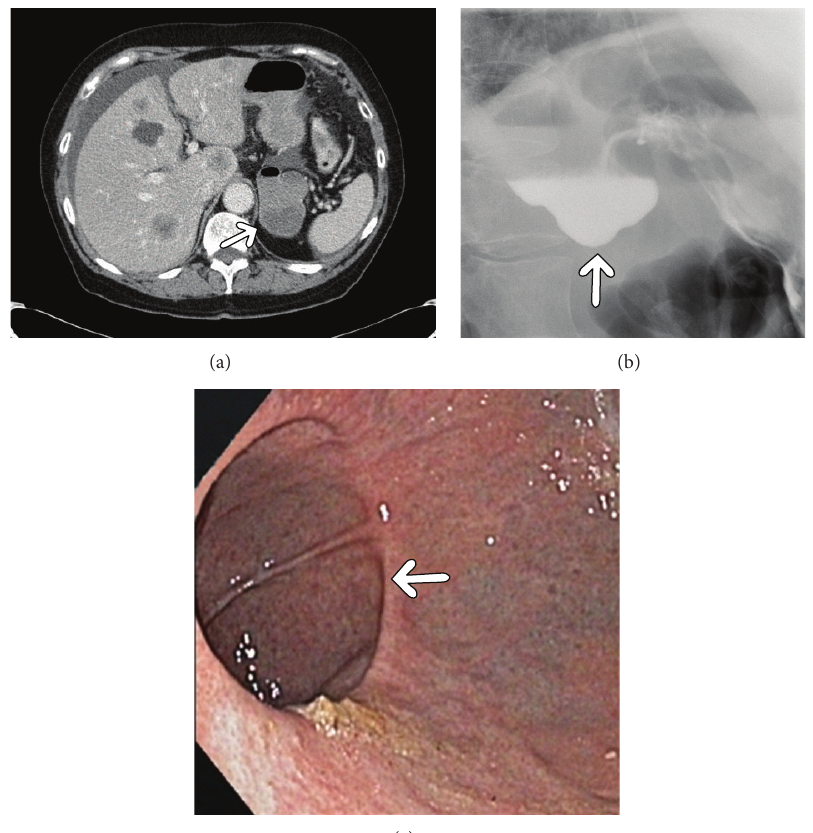
Figure 3: Imaging findings in a 60-year-old woman with known history of lung cancer. (a) Computer tomographic scans presenting a large gastric diverticulum (arrows). (b) Upper gastrointestinal investigation with contrast showing a gastric diverticulum in the cardia on the posterior gastric wall below the esophagogastral junction (arrow). (c) Endoscopy finding with entry of the diverticulum (arrow). structures [7]. Upper gastrointestinal contrast examinations typically document a contrast filled sack suggesting GD [3,